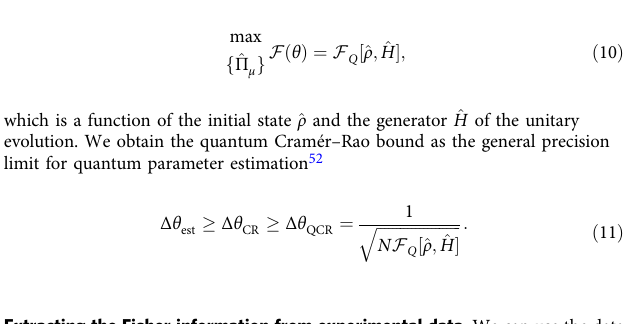
auxiliary states available in 25 Mg + . However, other techniques for phonon counting up to n = 10 by exploiting trap induced Kerr-nonlinearities have been demonstrated 46 and modi fi cations using laser-induced Kerr-nonlinearities 48 combined with continuous dynamic decoupling techniques 49 might be an option for future implementations.